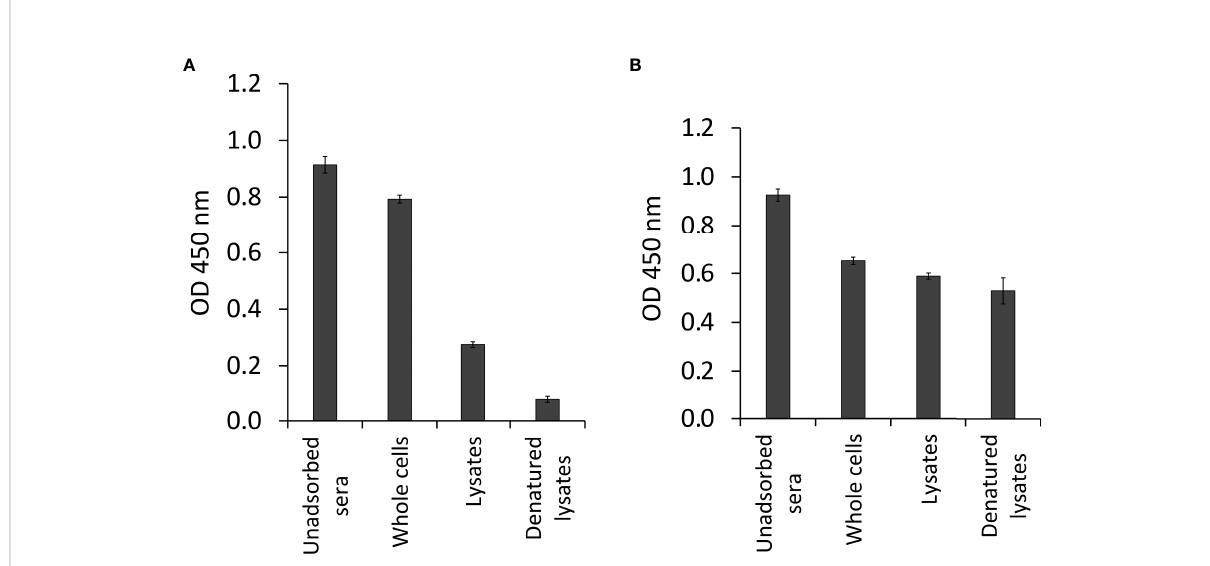
FIGURE 2 Antibody determination of pooled sera from infected brown trout after sequential adsorption steps by indirect ELISA. (A) pooled sera adsorbed by three different forms of T. bryosalmonae (native parasite sac whole cells, ultrasonic lysates, and heat-denatured lysates), and (B) pooled sera adsorbed by three different forms of E. coli XL1-Blue (native bacterial whole cells, ultrasonic lysates, and heat-denatured